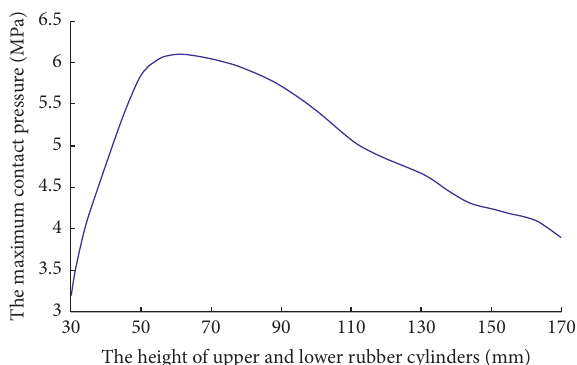
Figure 15: The relationship between the maximum contact stress and the height of the rubber cylinder.